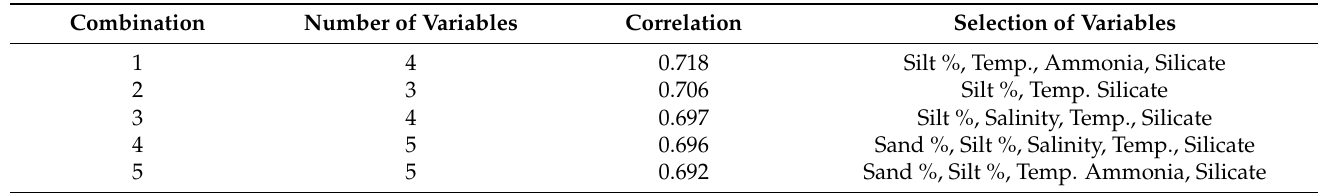
Table 4. Top five combinations of environmental, nutrient and sediment variables that best explained the macrobenthic invertebrates’ patterns in the four study areas in the two